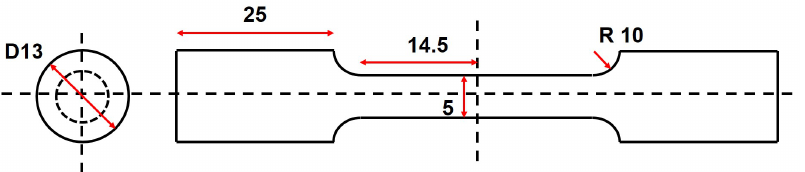
Figure 3. Sketch for final tensile specimen designed as per ISO 6892-1:2019 (all dimensions in mm).